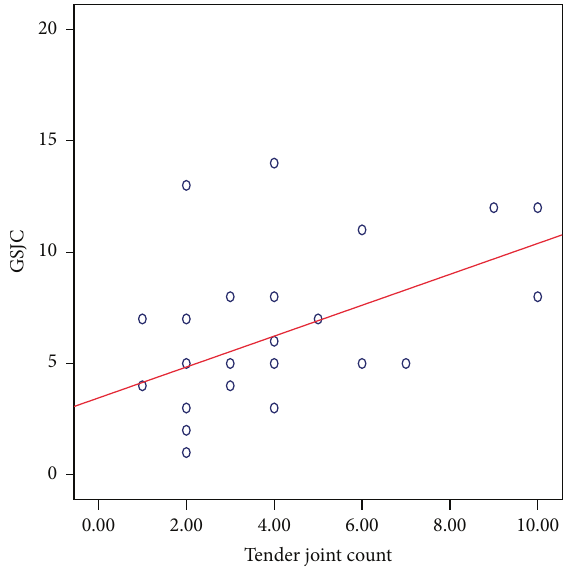
Figure 6: Relation between GSJC (taken from 28 MCP, PIP, and DIP joints)andDAS28scorein30patientswithPsA.Spearman’s 𝜌 :0.398; 𝑃 : 0.029 suggesting a significant correlation.